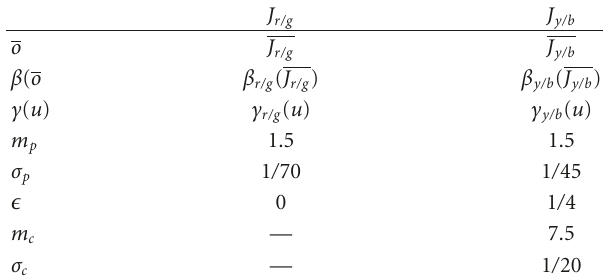
Table 1: Parameters for